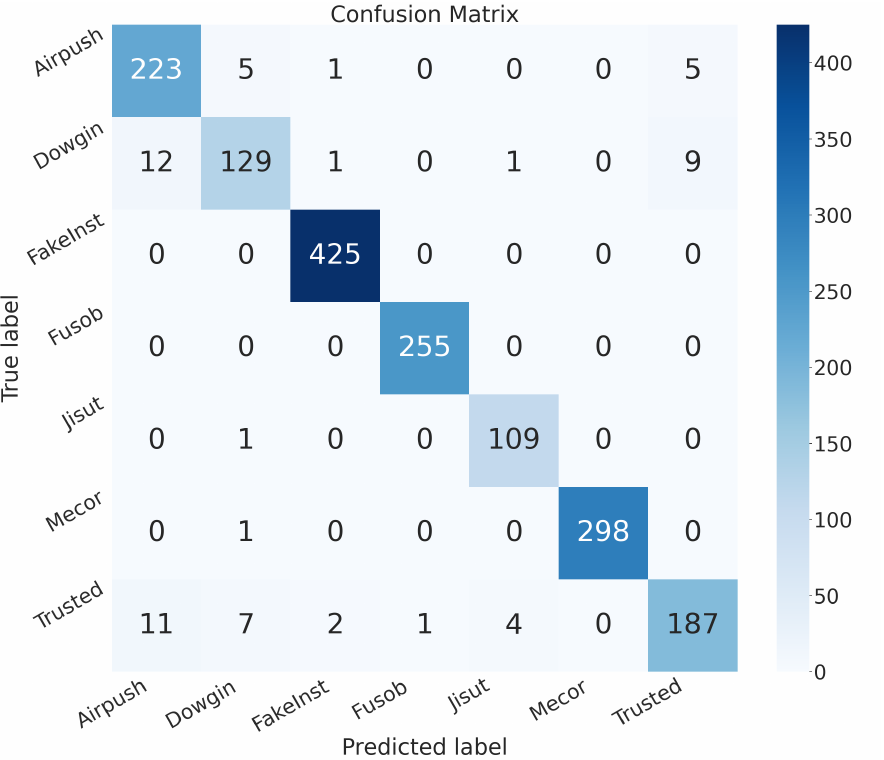
Figure 6. Confusion matrix obtained with the Standard-CNN model for the family classifi- cation task.